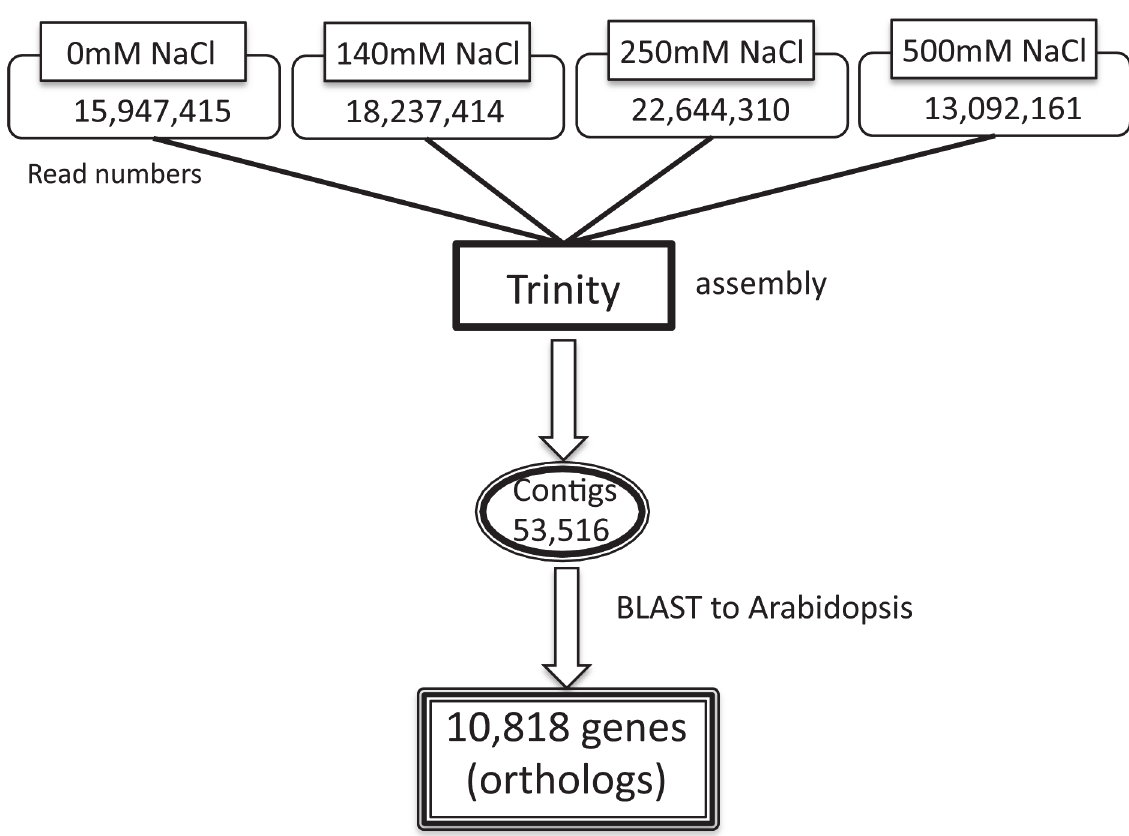
Fig 2. Flowchart of the experimental design used to obtain transcriptome data of the response of ice plant to salt stress. Trinity software was used for the assembly and blastx against the Arabidopsis protein database was used for annotation of the assembled ice plant